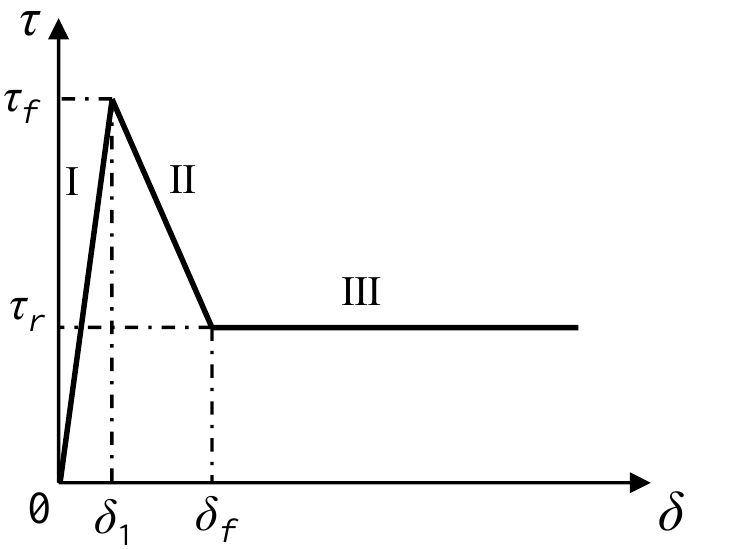
Figure 14. The tri-linear bond-slip model.